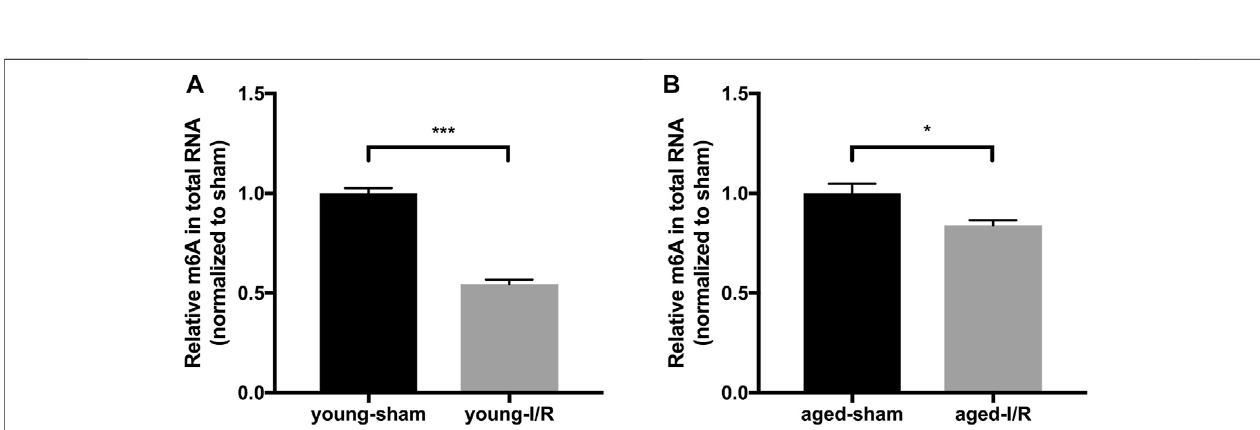
FIGURE 3 | Age-related differences in global m6A RNA methylation in response to acute myocardial I/R injury. n (cid:1) 5. Results are presented as mean ± standard error of the mean (SEM). * p < 0.05; *** p < 0.001.